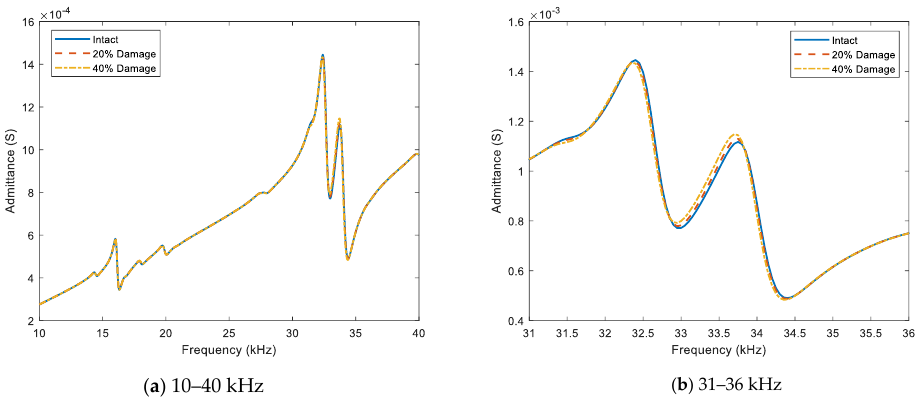
( b ) RMSD vs. Damage Figure 6. RMSD metric of numerical admittance responses under loading and damage cases.